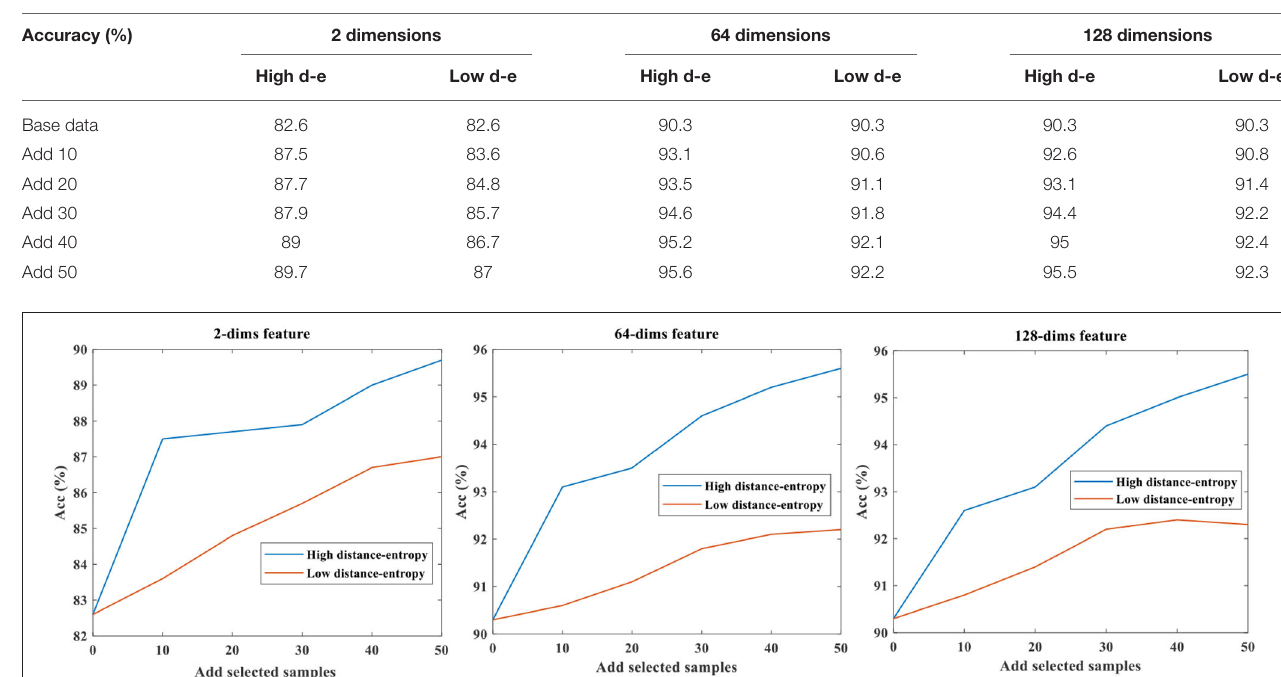
TABLE 2 | Results under different mapping feature dimensions.